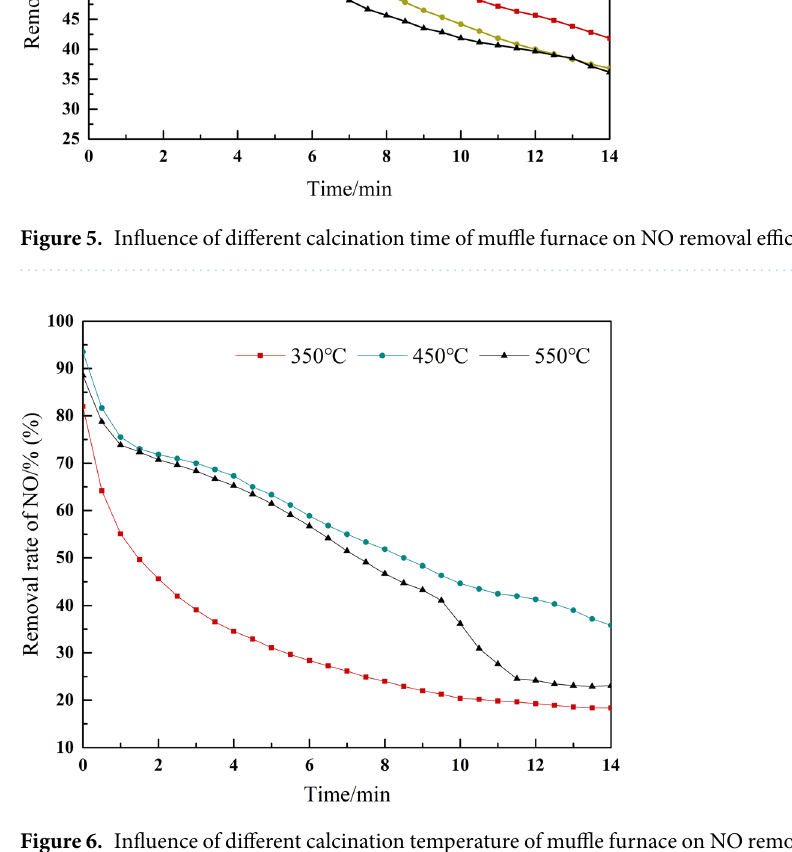
Figure 6. Influence of different calcination temperature of muffle furnace on NO removal